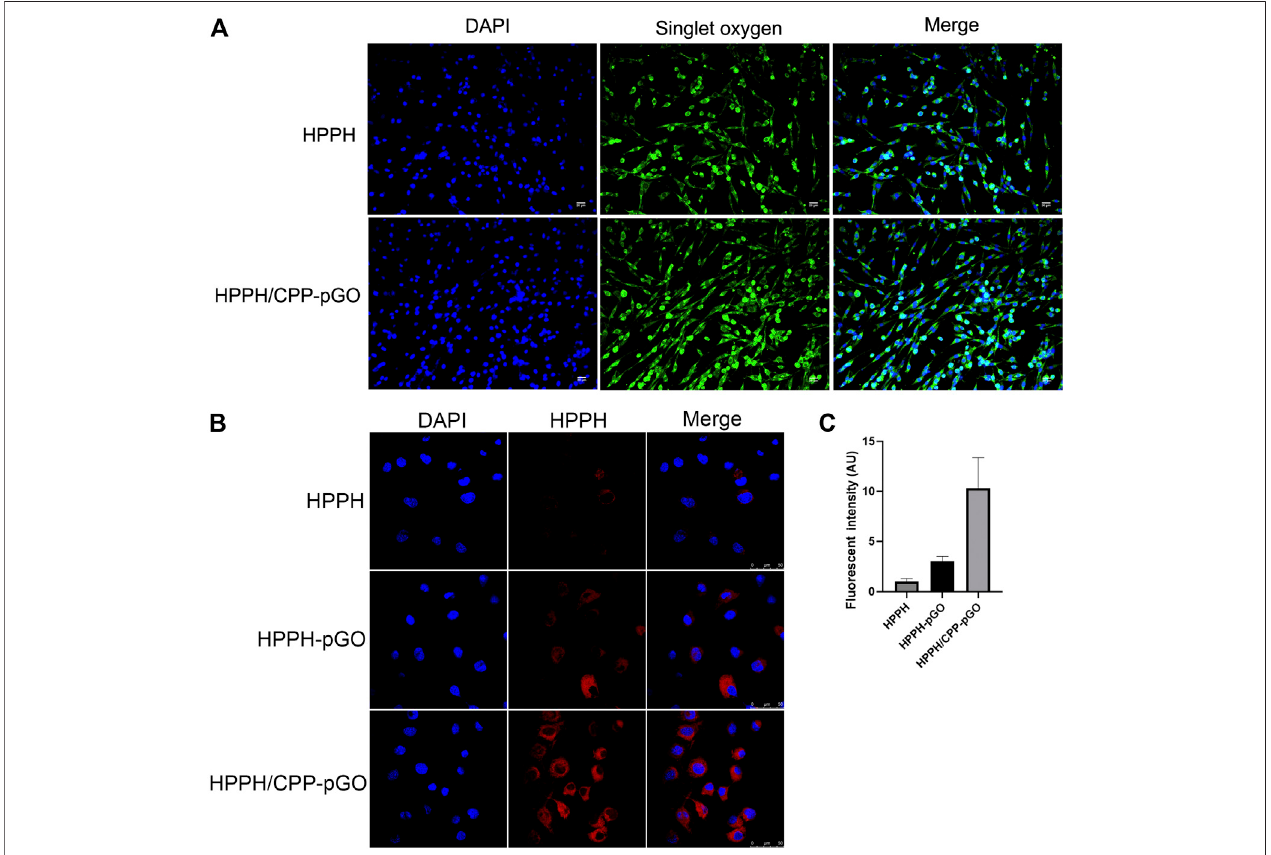
FIGURE 2 | Cellular uptake of HPPH by MG-63 cells. Confocal images of MG-63 cells treated with HPPH, HPPH-pGO, or HPPH/CPP-pGO at 1 μ M of HPPH.